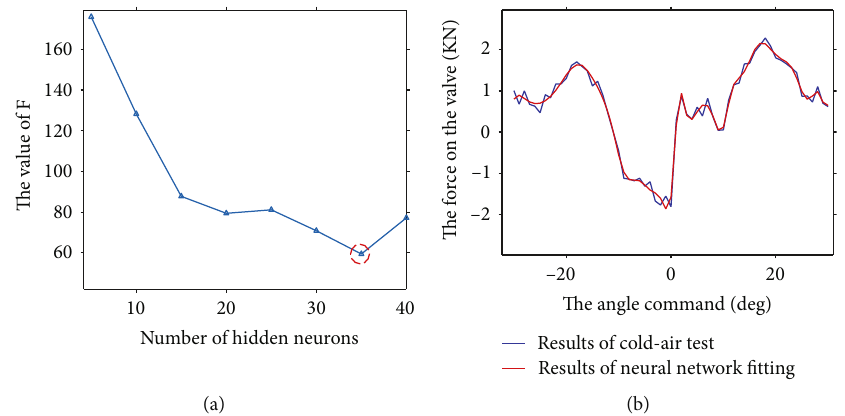
Figure 16: Fitting of lateral force by a neural network. (a) The relationship between F value and hidden layer. (b) Fitting e ff ect of 35 hidden